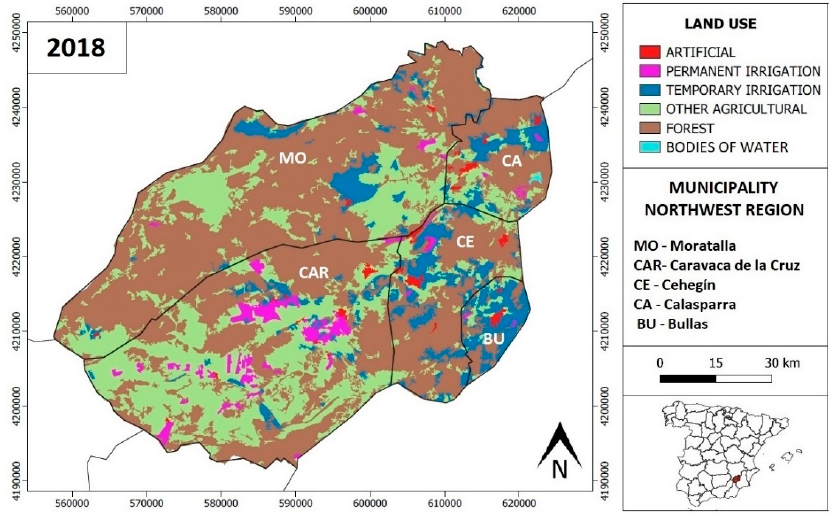
Figure 8. Coverage and land uses 2018. Fuente: Corine Land Cover.